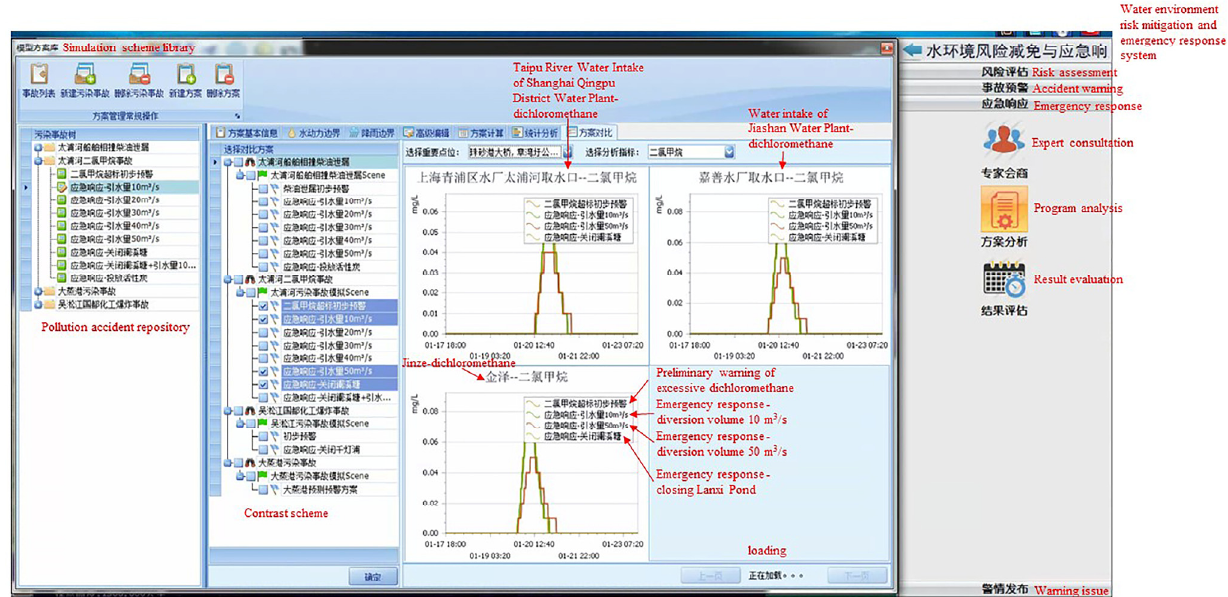
Figure 14. Comparison of emergency response plans for pollution accidents in the Suhu transbound- ary area of the Taipu River.